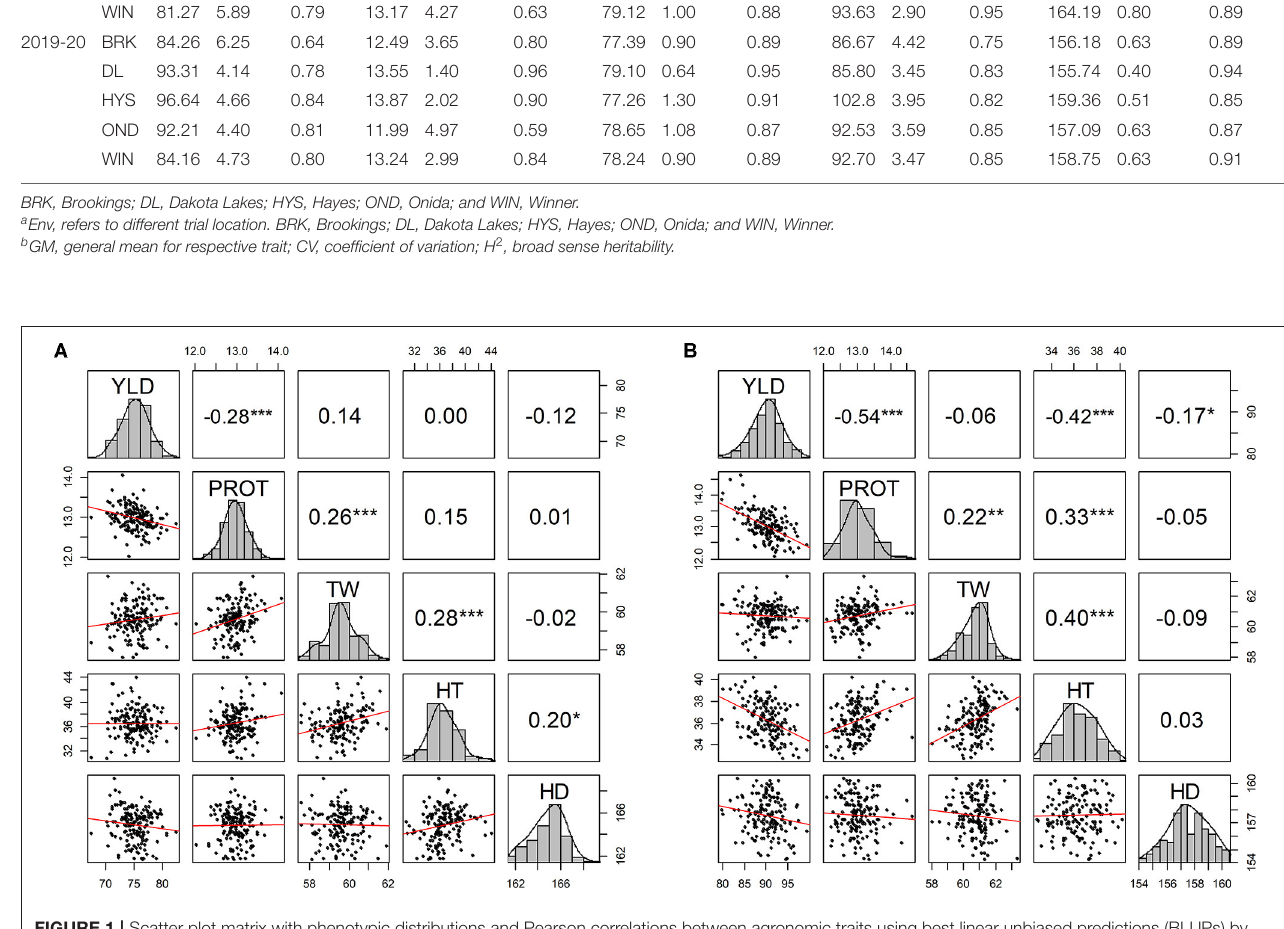
FIGURE 1 | Scatter plot matrix with phenotypic distributions and Pearson correlations between agronomic traits using best linear unbiased predictions (BLUPs) by combining five experimental sites (BRK, DL, HYS, OND, and WIN) (A) from the growing season of 2018–19 and (B) from the growing season of 2019–20. YLD, grain yield; PROT, grain protein content; TW, test weight; HT, plant height; and HD, days to heading. * P ≤ 0.05, ** P ≤ 0.01, *** P ≤ 0.001, **** P ≤